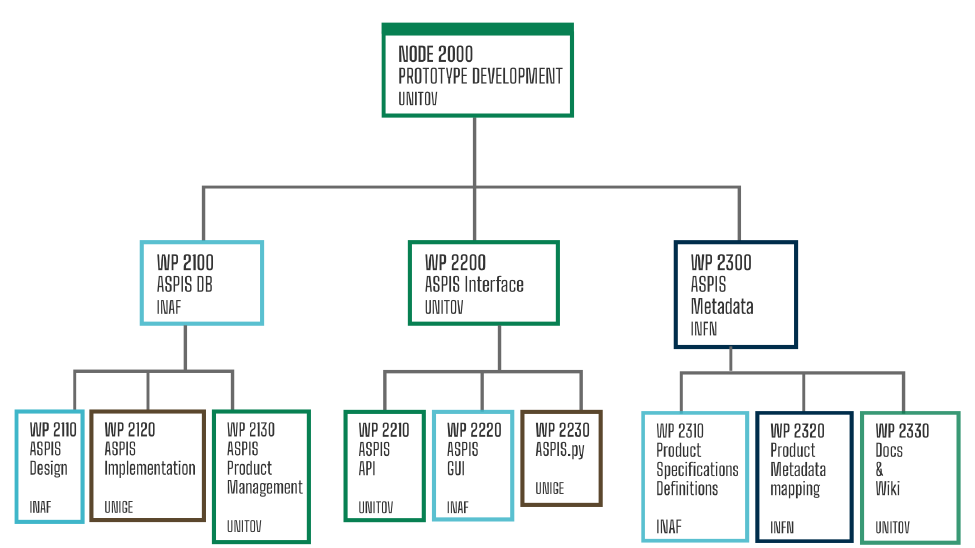
Figure 3. Work breakdown structure of NODE 2000. Colors indicate institutions described in the legend of Figure 2.